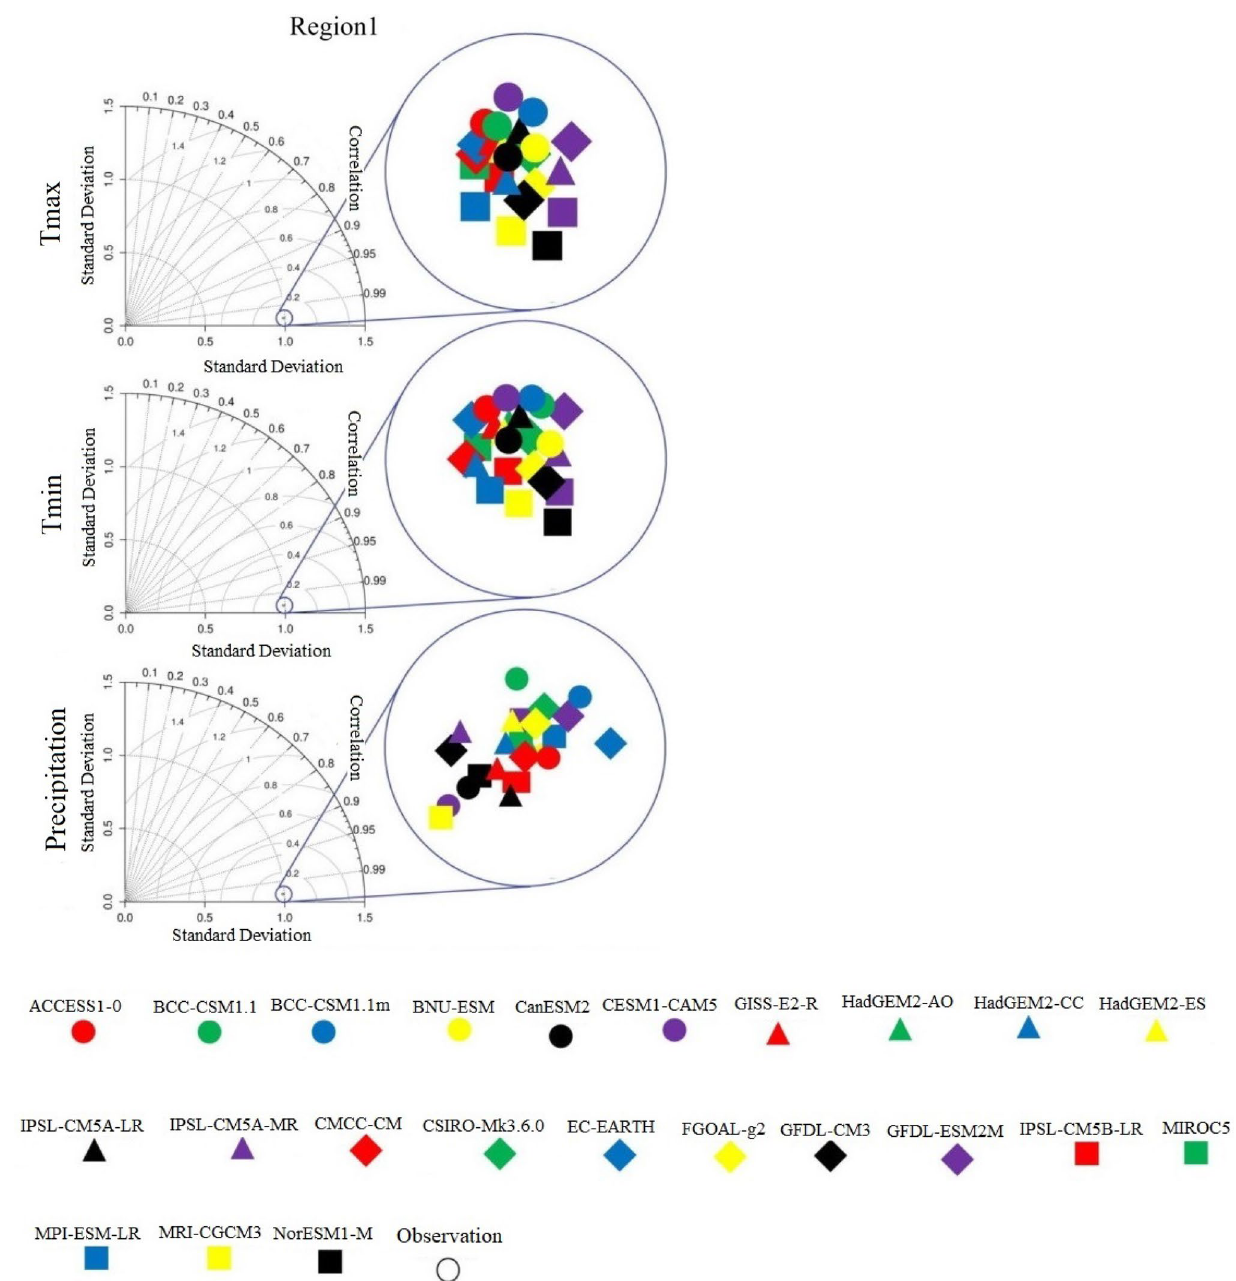
Fig.4 Taylor diagrams for PCP, Tmax, and Tmin of the region1 in the baseline period